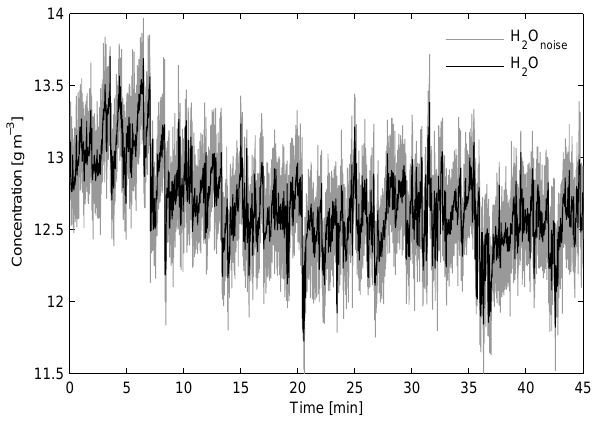
Fig. 1. Example of the original H 2 O measurements with the IRGA and the corresponding manipulated signal containing added noise (9 August 2007 12:00–12:45). The standard deviation of H 2 O noise is 14% higher than that of H 2